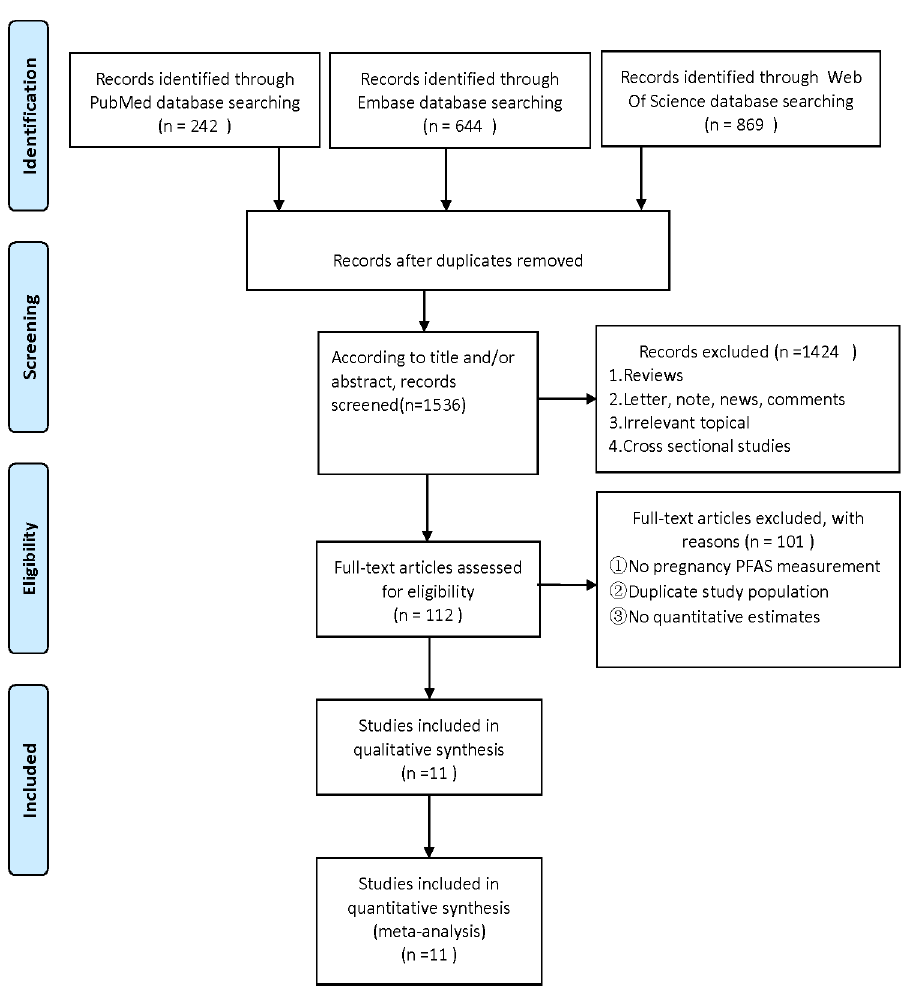
Figure 1. Flowchart for the screen of included studies in the current meta-analysis [59] . Table 1. The included studies on the association between prenatal PFAS exposure and neurobehav- ioral problems in offspring.